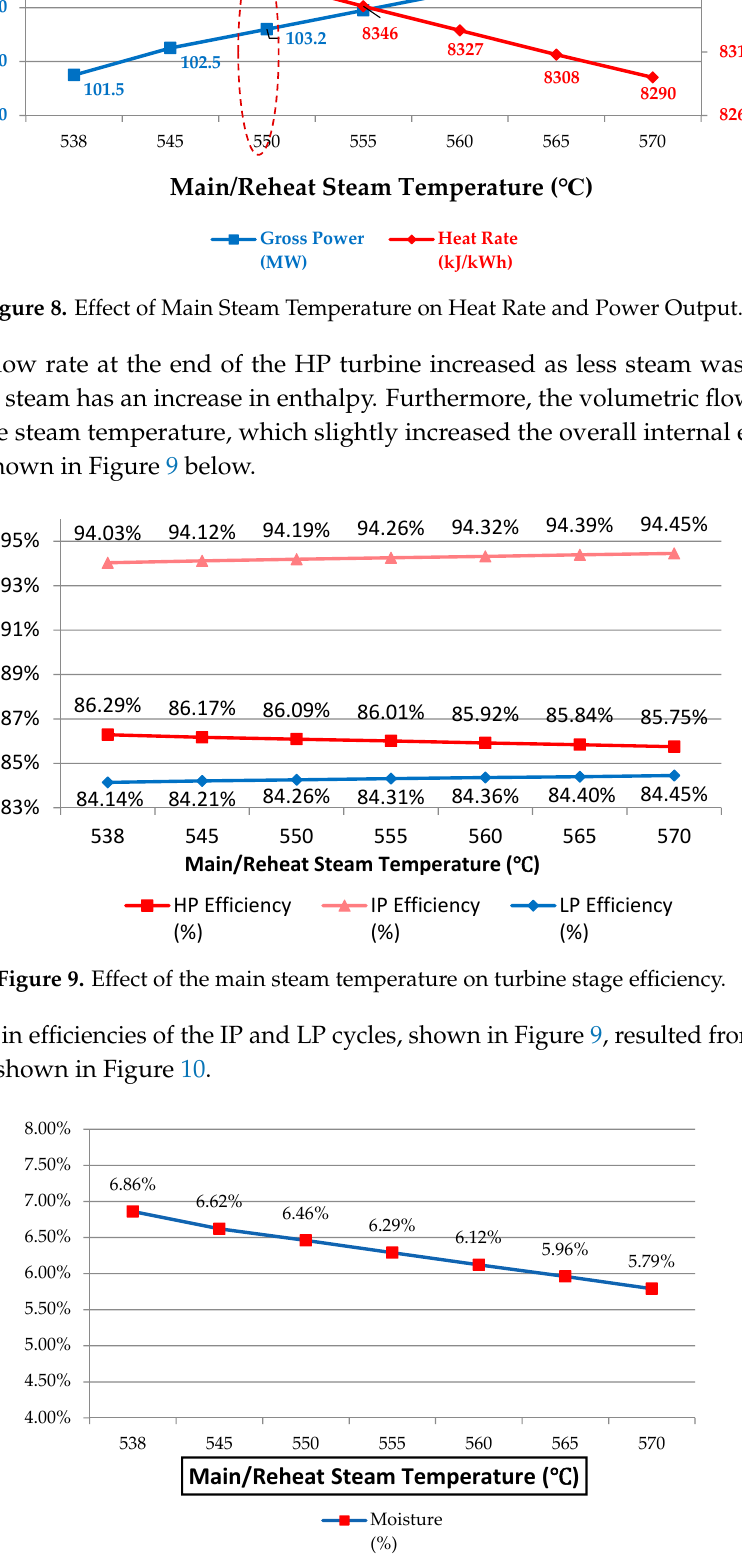
Figure 10. Effect of the main steam temperature on moisture at the end of the low-pressure turbine cycle.